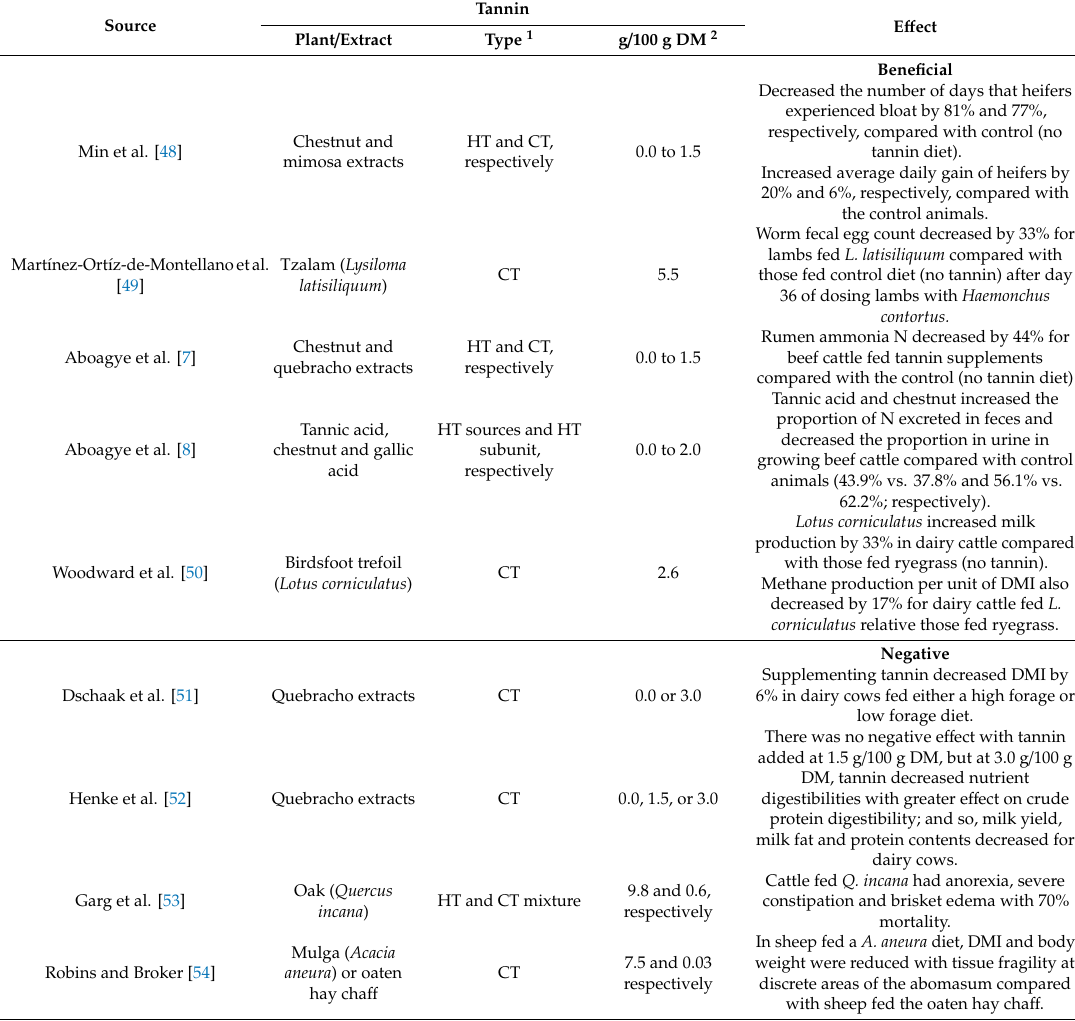
Table 2. Summary of potential nutritional and toxicity e ff ects of tannins in